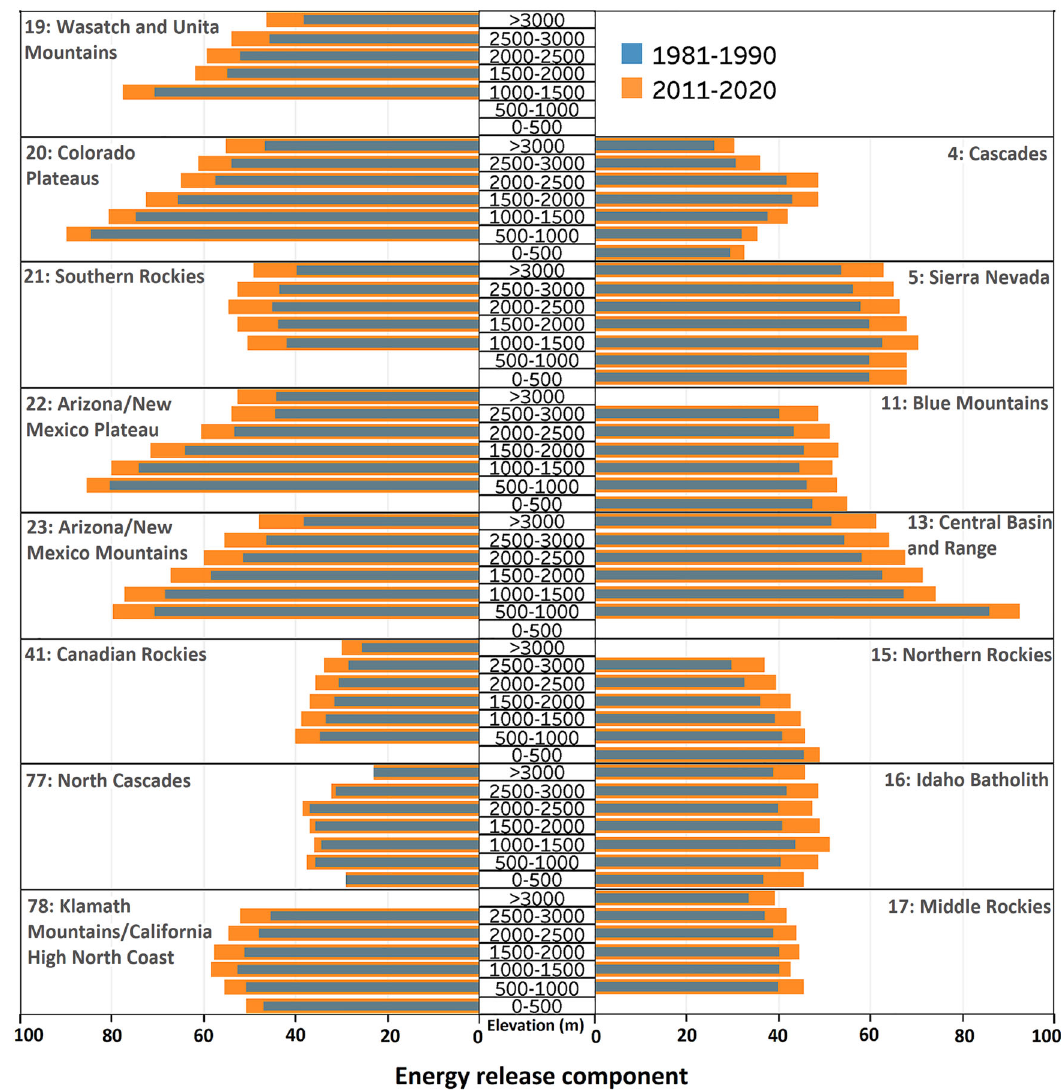
Fig.2|Decadalaveragewarm-seasonenergyreleasecomponent(ERC)ineachelevationbandineachecoregion. Resultsfor1981 – 1990and2011 – 2020areshownin blue and orange colors, respectively. “ m ” stands for